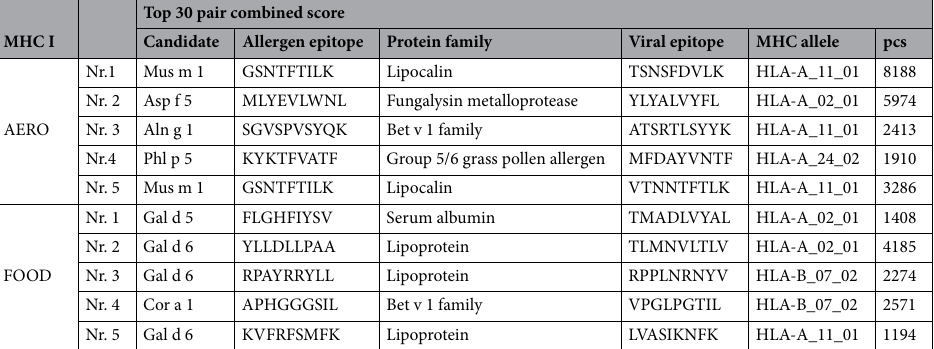
Top 30 pair combined